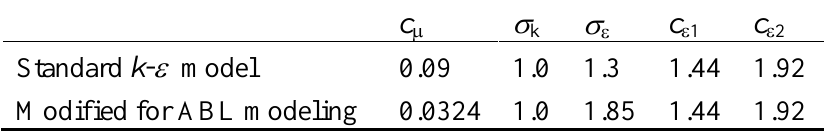
Table 3. k - ε turbulence closure parameters for RANS modeling [67].